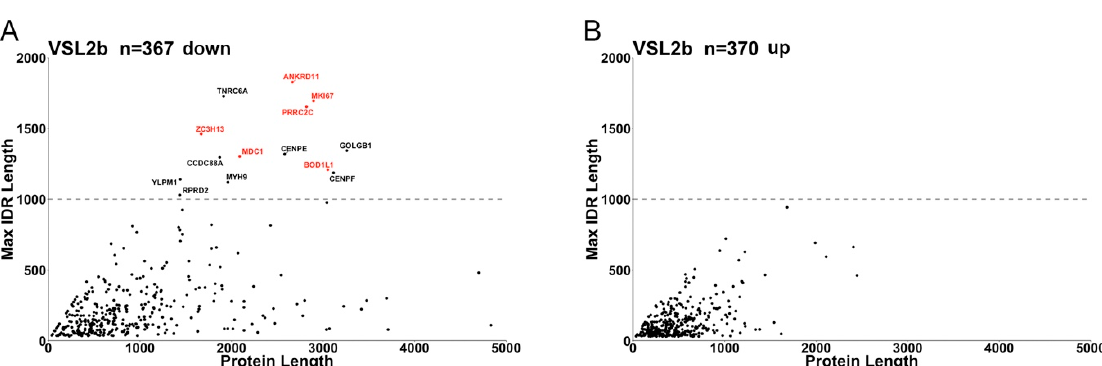
Figure 3. Comparison of proteins encoded by down- or up-regulated adhesion-regulated genes with regard to longest IDR length per protein and protein length. IDR-containing proteins encoded by ( A ) down-regulated adhesion-regulated genes (adsu_down) and ( B ) up-regulated adhesion-regulated genes (adsu_up) are shown. Of the 14 proteins in ( A ) for which the maximum IDR length is greater than 1000 residues (above dotted line), 6 proteins (red text) were also found in the sets of 14 proteins with the longest IDRs predicted by the PV2 and PrDOS predictors.